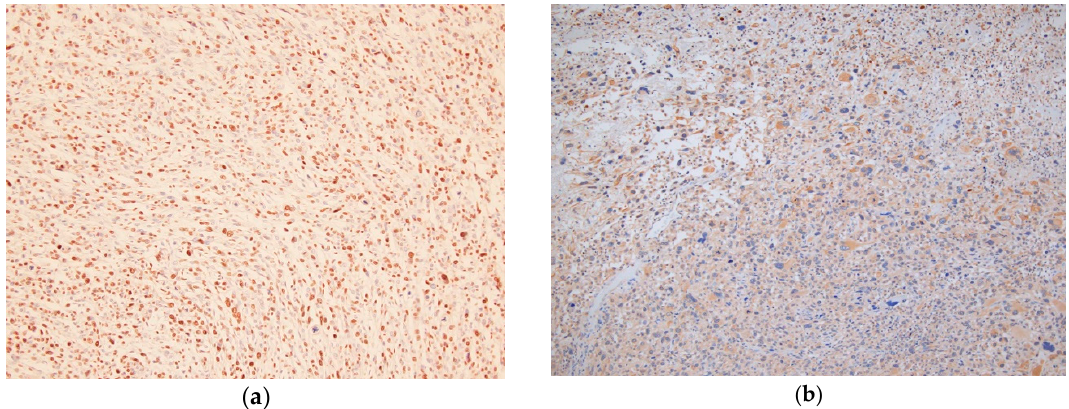
Figure 3. Immunohistochemical staining of IL-6 and IL-6R ( a ) Immunostaining for IL-6 (×100). High expression of IL-6 in tumor tissue. ( b ) Immunostaining for IL-6R (×100). High expression of IL-6R in the tumor tissue.